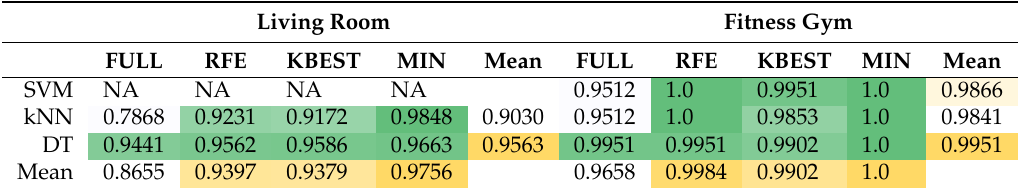
Table 5. Feature selection results for the living room and the fitness gym. Individual scores are shown in green, and mean scores in yellow. A stronger color indicates a higher